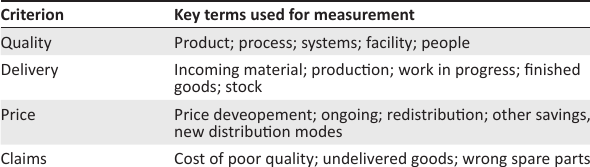
TABLE 2: Criteria used most